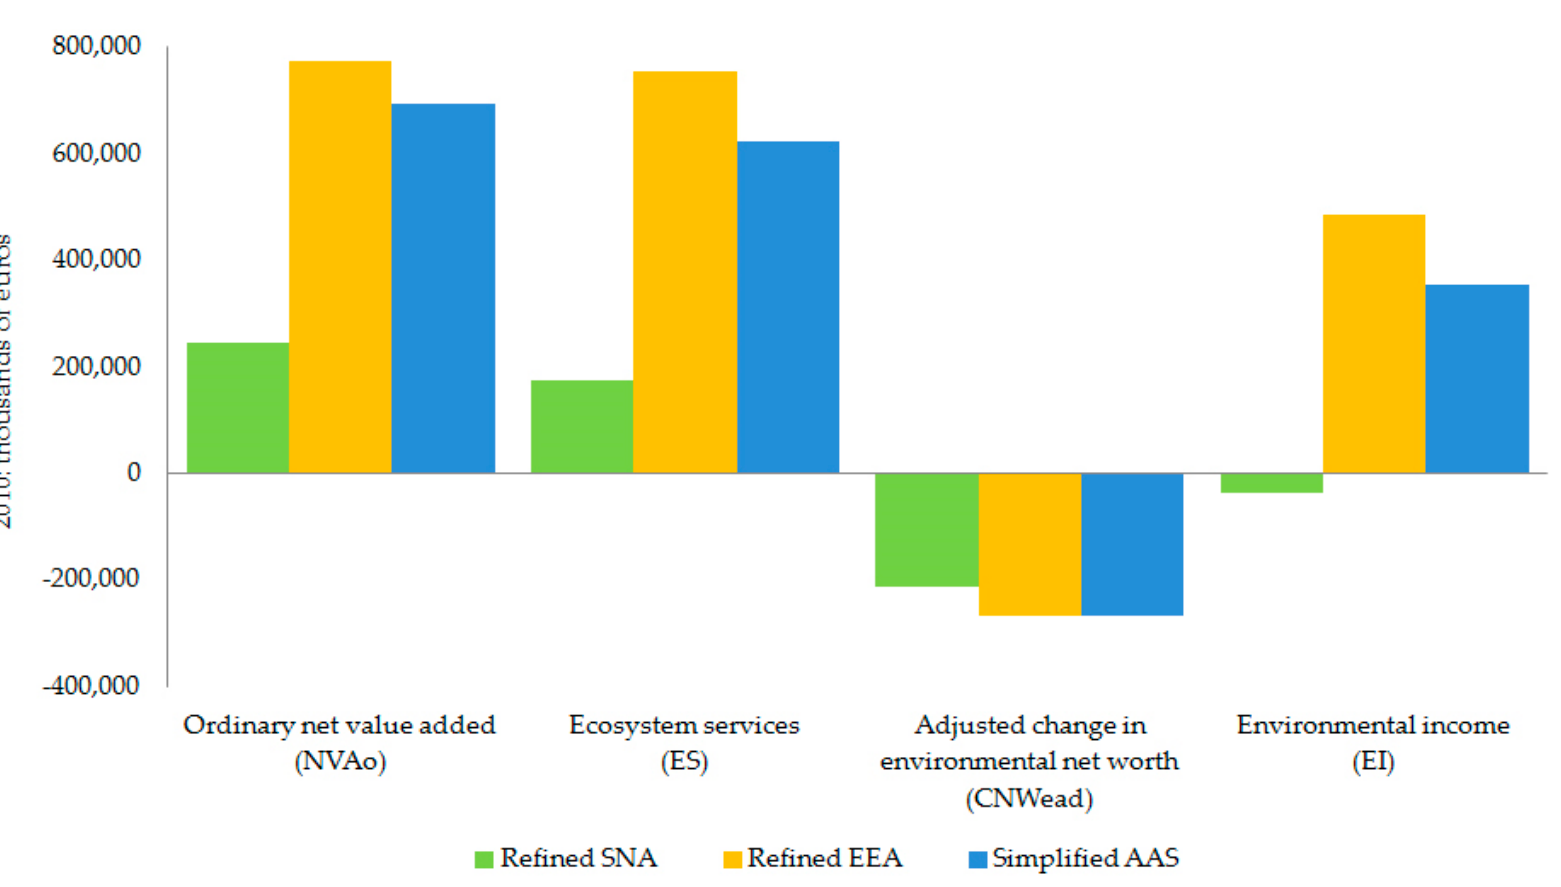
Figure 3. Selected environmental–economic indicators measured using rSNA and rEEA versus sAAS in holm oak open woodlands in Andalusia, Spain (2010: thousands of euros). rSNA is the refined System of National Accounts, rEEA is the System of Environmental Economic Accounting–Experimental Ecosystem Accounting, and sAAS is the simplified Agroforestry Accounting System. Source: Own elaboration based on [8]. Andalusian holm oak woodland surface: 1,408,170 hectares.